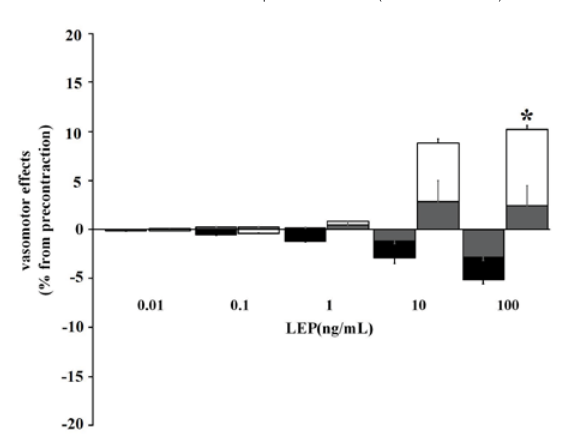
Figure 3. Effects of N ω -nitro-L-arginine-methyl ester (0.1mM) on leptin (LEP)-induced vasodilatation on phenylephrine- precontracted pulmonary artery rings in the absence (empty bars) or in the presence of apelin (filled bars) (n=6). The gray bars accompanying the empty or filled bars represent the effects of vehicle (alone or in the presence of apelin). *: P<0.05 as compared with vehicle. The LEP or vehicle effects are expressed as a percentage of Phe-induced precontraction (mean ± S.E.M.)